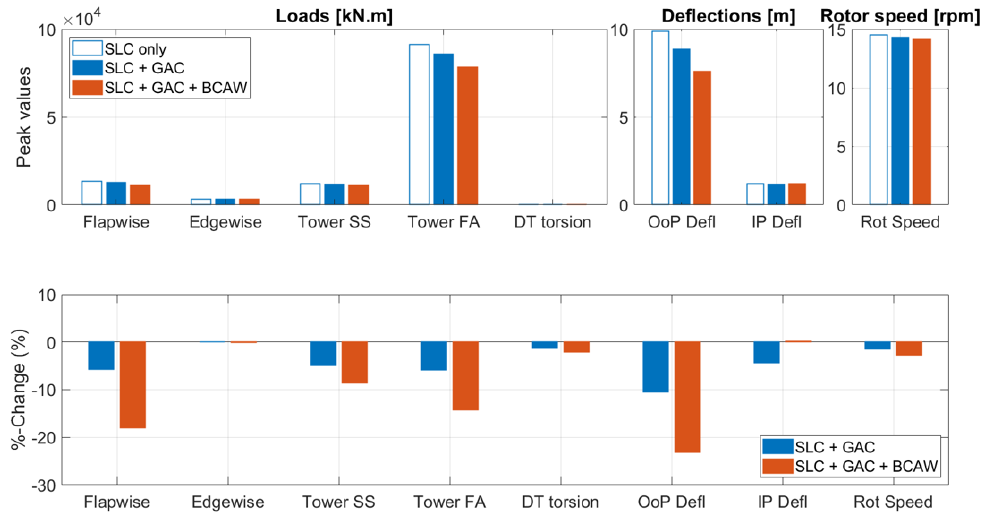
Figure 11. Variation of the maximum absolute transient (peak) values of the primary and secondary metrics under gust wind with different control architectures. Top—Peak dimensional values; Bottom— Percentage changes with respect to ‘SLC Only’